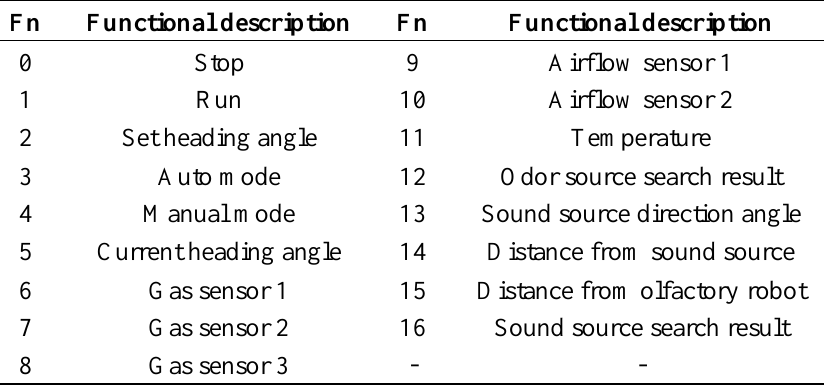
Table 5. Function definition of